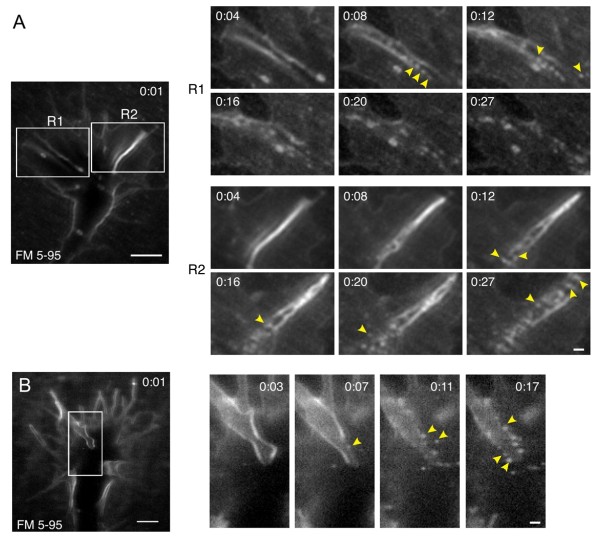
Small endocytic vesicle hot-spots at dorsal ridges of the growth cone. (A-B) Time-lapse confocal images of FM 5-95 internalization show numerous small endocytic vesicles that form at dye-labeled dorsal ridges of the growth cone. For each example (A-B), the frame showing initial membrane labeling immediately following the focal dye pulse is shown at the left (0:01). The boxed regions (left panels) are shown at higher magnification in the right panels. Time, following the initial membrane labeling, is indicated for each frame in minutes:seconds. In each example, the peripheral filopodia are slightly below the dorsal focal plane in the confocal section. Note the radial progression (inside-out) of endocytic vesicle formation, which is indicated by the yellow arrowheads marking nascent vesicles. Time-lapse movies are shown in Additional file 1. Scale bars, 5 μm (left), 1 μm (right).